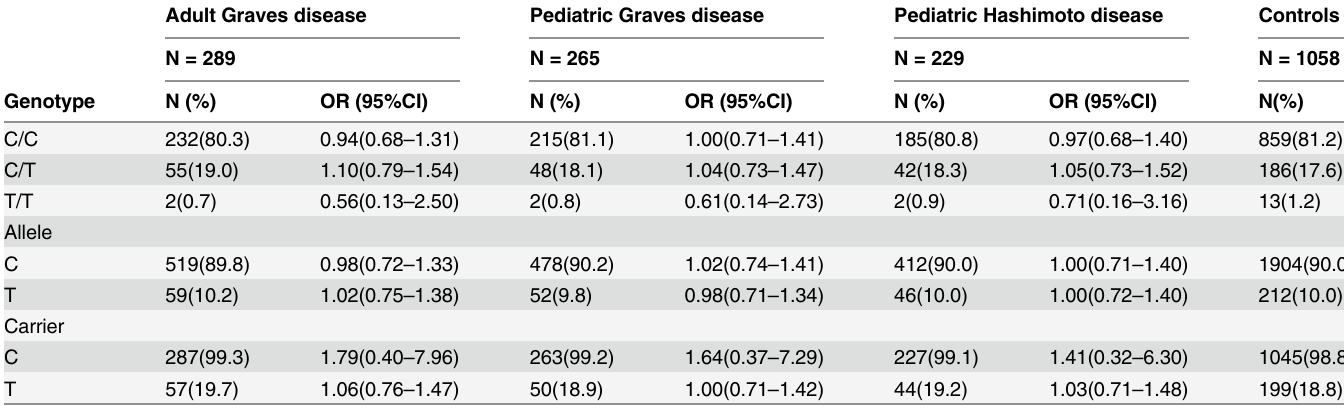
Table 1. Polymorphism of -318 C/T (rs5742909) of the CTLA4 gene in adult Graves disease, pediatric Graves disease, Hashimoto disease patients and controls.